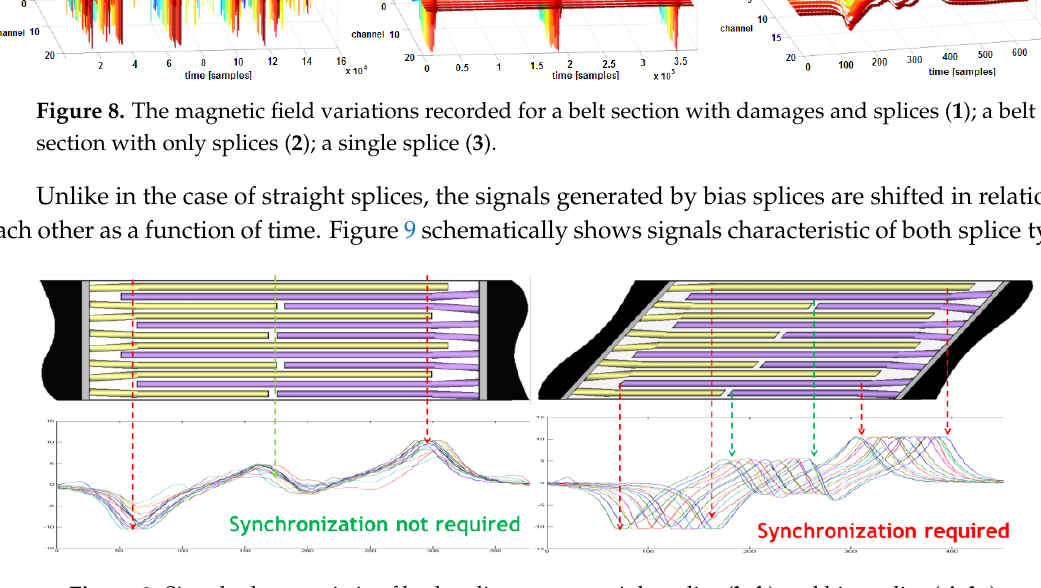
Figure 9. Signals characteristic of both splice types: straight splice ( left ) and bias splice ( right